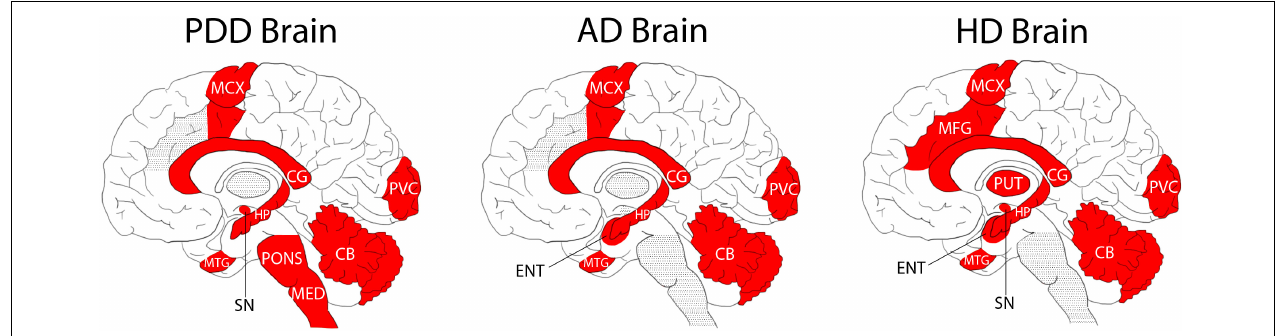
FIGURE 2 | Regional Distribution of Measured Tissue Urea Increases in the PDD, AD, and HD Brain. Areas shaded in red denote significant increases in urea compared to intra-cohort controls. Areas shaded in grey were not investigated in the illustrated studies.